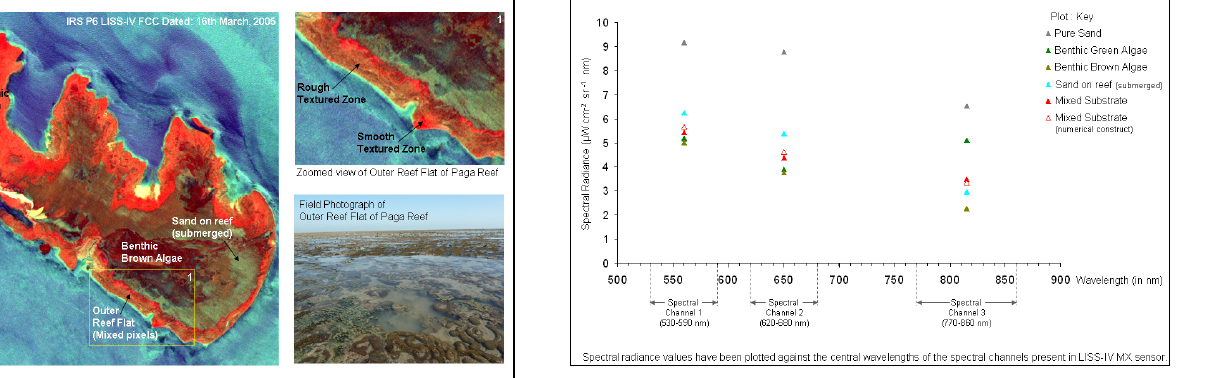
Figure 2. Appearance of reef substrates on LISS-IVMX FCC and on field